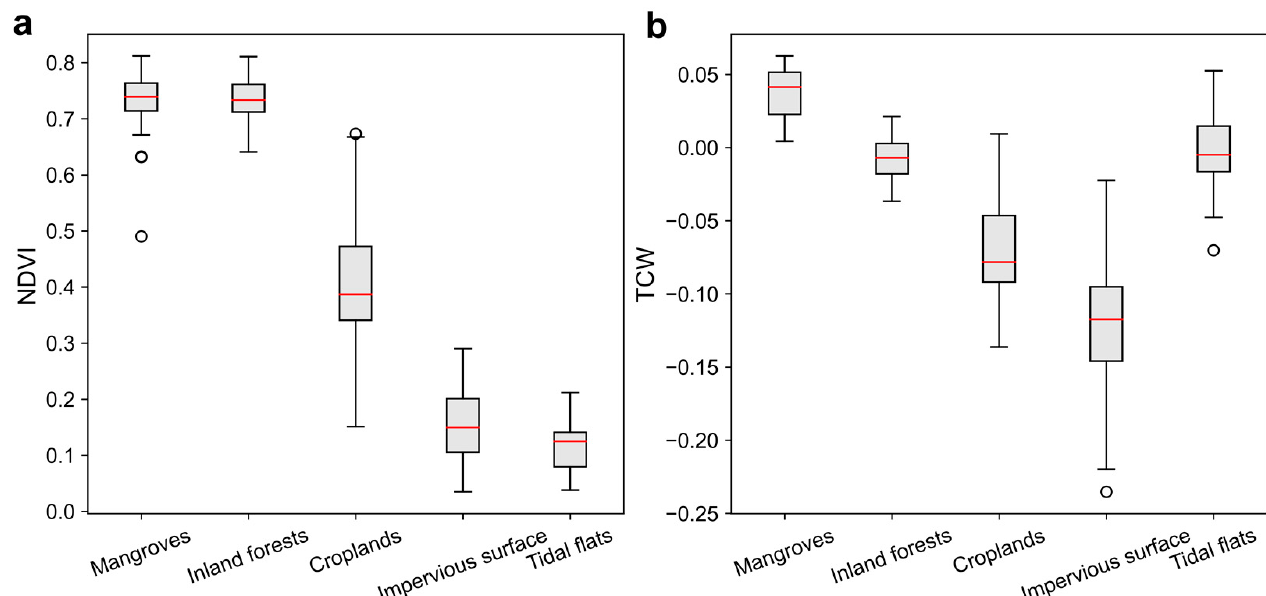
Figure 5. ( a ) NDVI and ( b ) TCW of five land-cover types. Boxes represent data within the 25th and 75th percentile, red lines show medians, and whiskers show 1.5 × the interquartile range. Data points beyond that range (outliers) are shown as dots. Indices were collected from the Landsat-8 median composite in 2022.